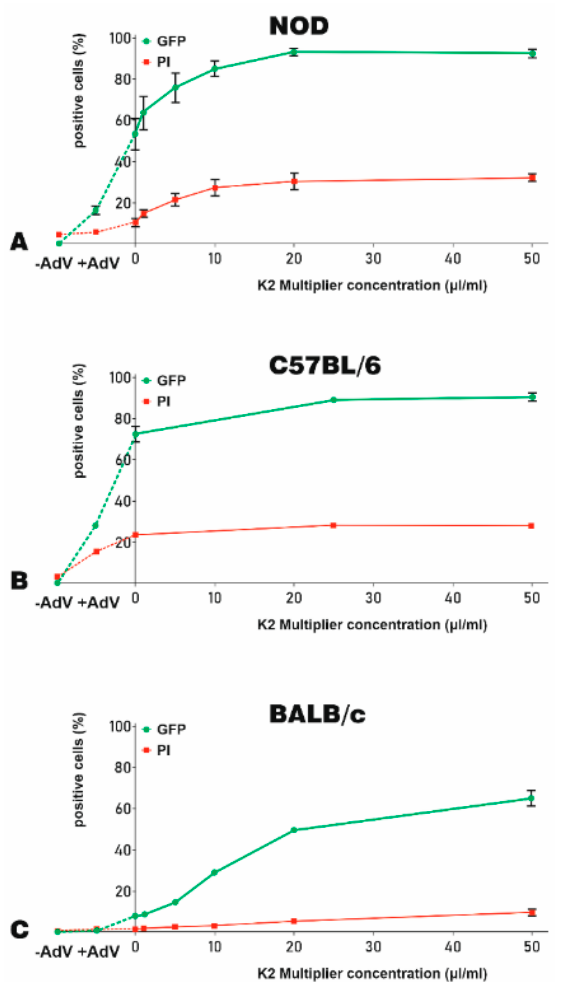
Figure 4. The optimization of K2M for adenoviral transduction of murine MSC. The efficacy of K2M to increase the adenoviral transduction of MSC-derived from NOD ( A ), C57BL/6 ( B ), and BALB/c ( C ) mice were expressed as % of GFP-positive cells (green lines). The K2M induced cytotoxicity was indicated by the % of PI-positive, dead cells (red lines). To optimize the concentration of K2M needed for transduction, MSC were incubated with increasing K2M concentrations (up to 50 µ L/mL) for 90 min. Then, the adenovirus–K2TR complexes (5 µ L/mL K2TR and 250 TU/cell adenoviral particle) were added to the cells. The percentage of GFP-positive cells and PI-positive cells at 48 h after transduction was determined by flow cytometry. The same fractions were evidenced also for untransduced cells ( − AdV) and NOD-, C57BL/6- and BALB/c-MSC transduced with the adenovirus alone (+AdV), which were linked by a dotted line in the left side of the